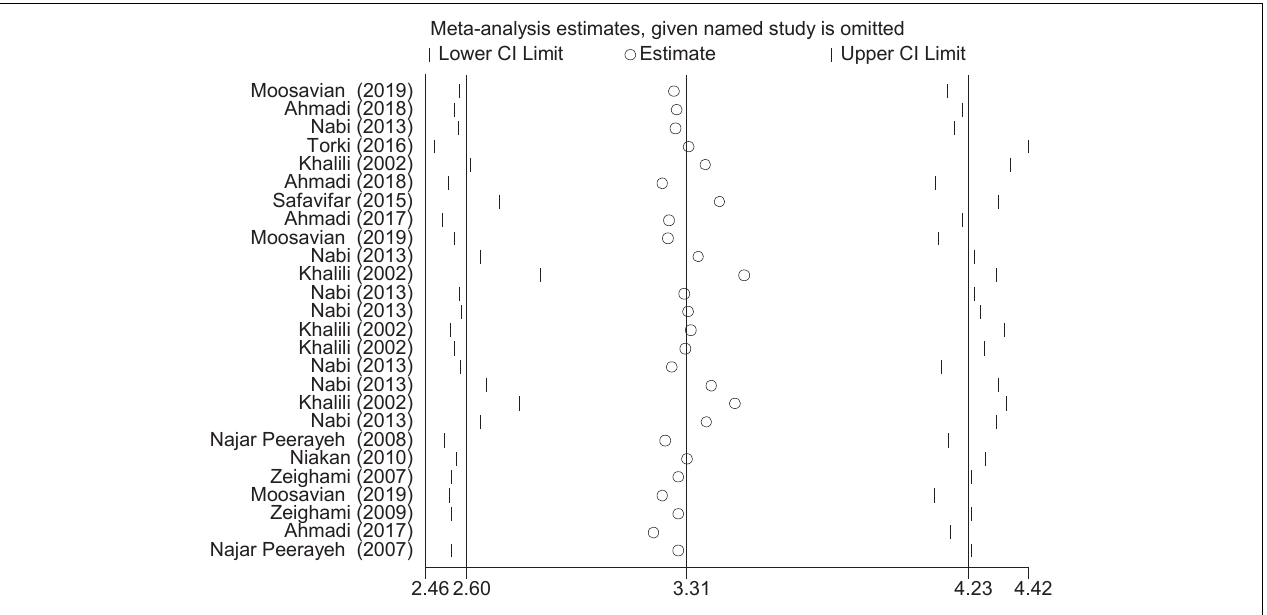
FIGURE 8 | Sensitivity analysis (overall estimation of the odds ratio of male infertility due to exposure to different bacteria).